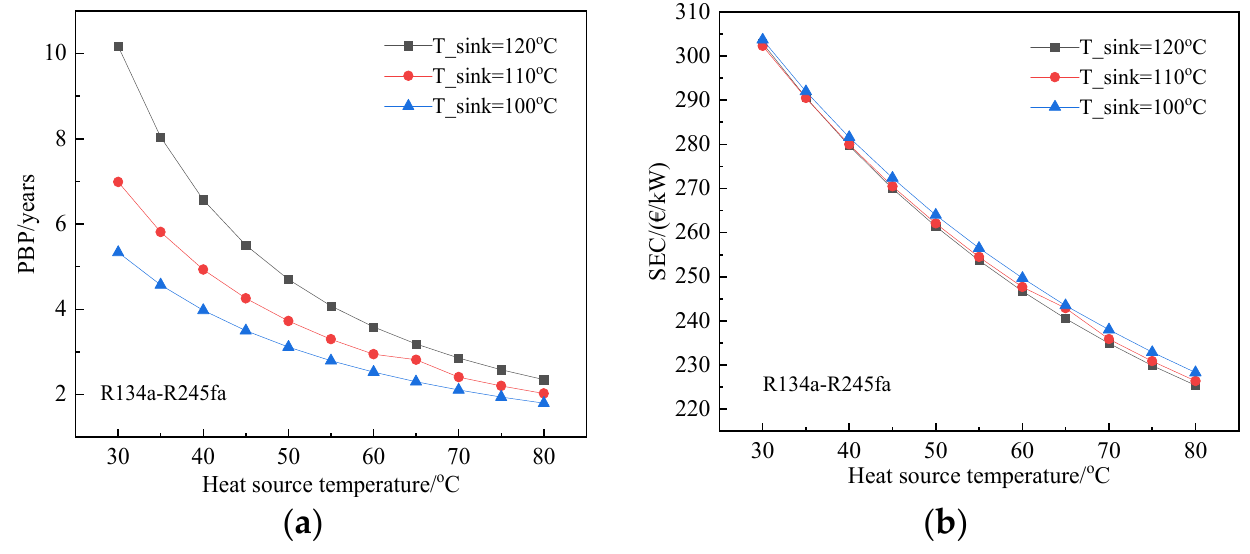
Figure 6. Effects of heat source/heat sink temperatures on the economic performance. ( a ) PBP at various heat source/heat sink temperatures. ( b ) SEC at various heat source/heat sink temperatures.